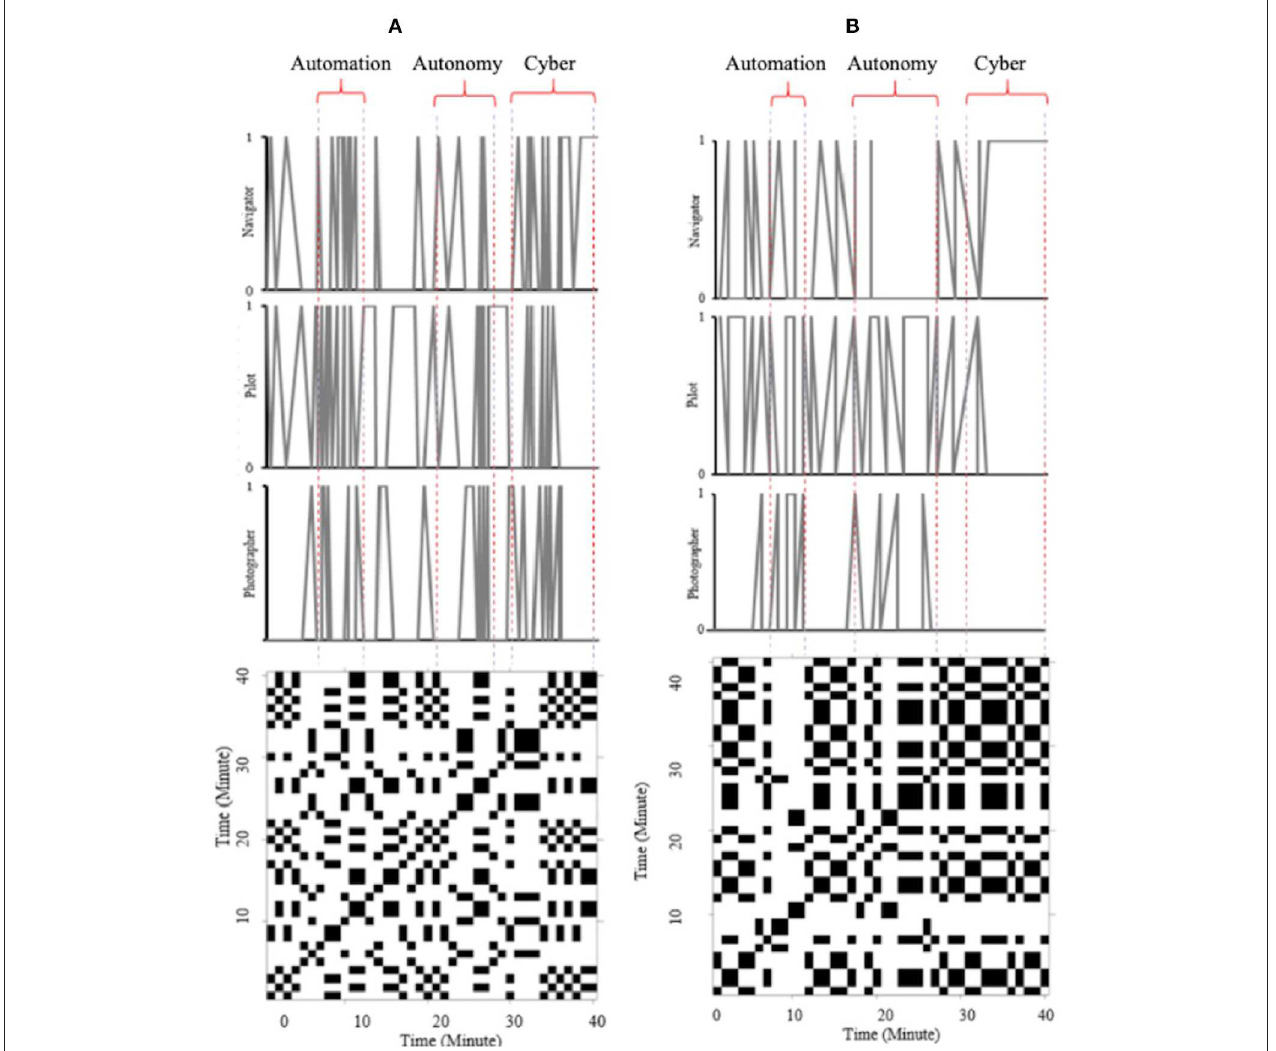
FIGURE 4 | Example Joint Recurrence Plots for two RPAS teams’ interactions: (A) high performing team (Mission 10—DET: 48%) overcame all three failures (automation, autonomy, and malicious cyber-attack); and (B) low performing team (Mission—DET: 54%) only overcame automation failure—Mission 10: length 40min (from Grimm et al., 2018b; reprinted with